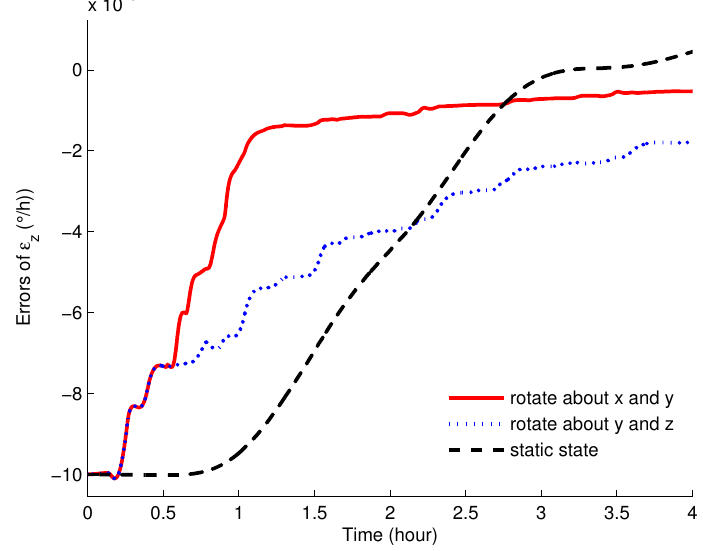
Figure 8. The estimated errors of the azimuth gyroscope drifts of the rotation and static